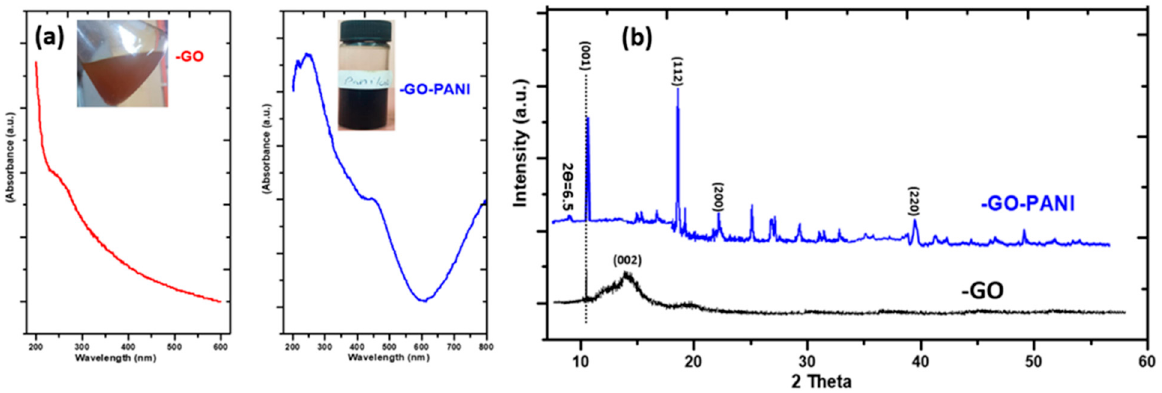
Figure 3. ( a ) UV- absorbance spectra and ( b ) X-ray diffraction (XRD) spectra of prepared GO and GO-PANI nanocompo- site.